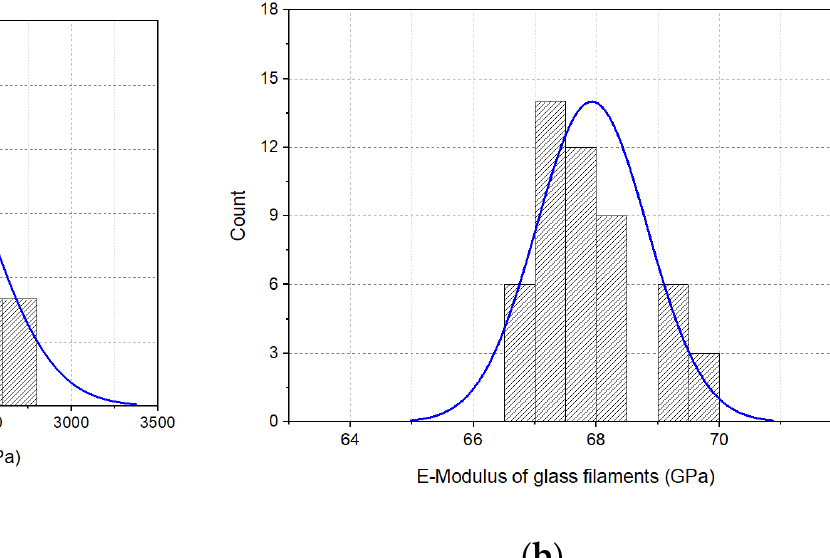
Figure 7. Tensile properties of stainless-steel filaments: ( a ) strength distribution curve and ( b ) E-modulus distribution curve.